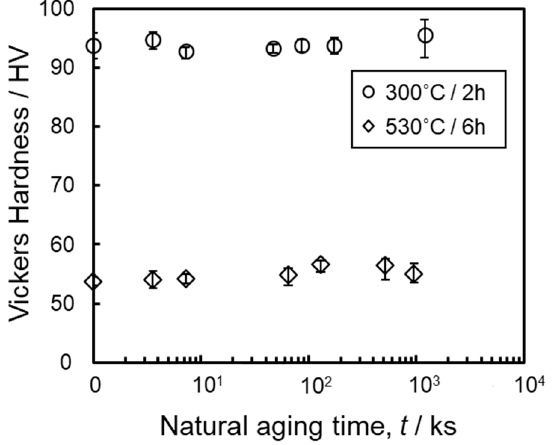
Figure 9. Change in Vickers hardness measured in the sections parallel to the building direction ( z axis) of 300 °C/2 h and 530 °C/6 h annealed samples as a function of aging time at ambient temperature.